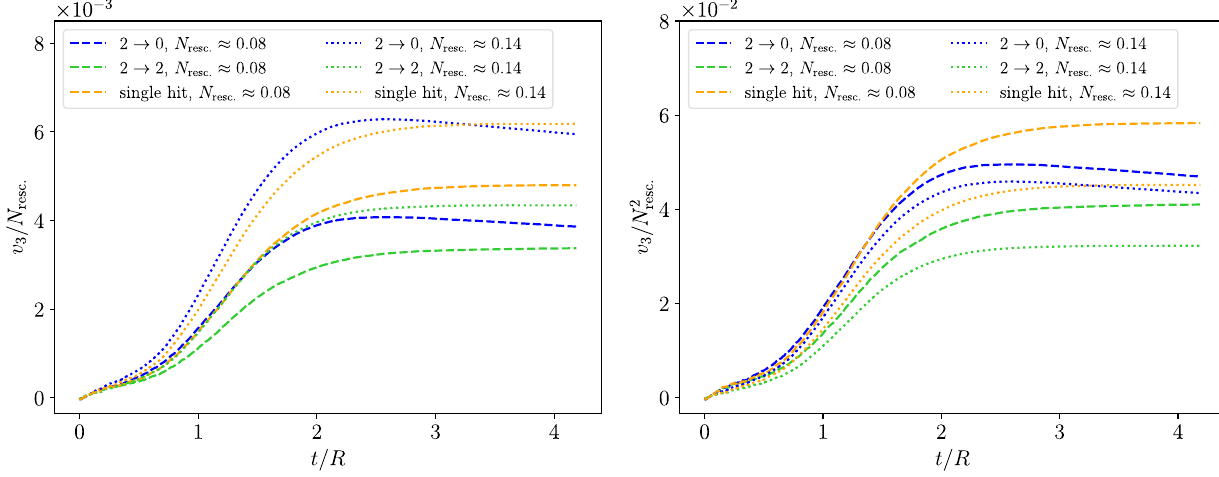
Fig. 6 Ratios v 3 ( t )/ N resc . (left) and v 3 ( t )/ N 2 resc . (right) in systems with initially ε 3 = 0 . 15 and on average N resc . ≈ 0 . 08 (dashed lines) or 0 . 14 (dotted lines) rescatterings per particle for the three scenarios of the transport cascade: 2 → 2 (green), 2 → 0 (blue), single hit